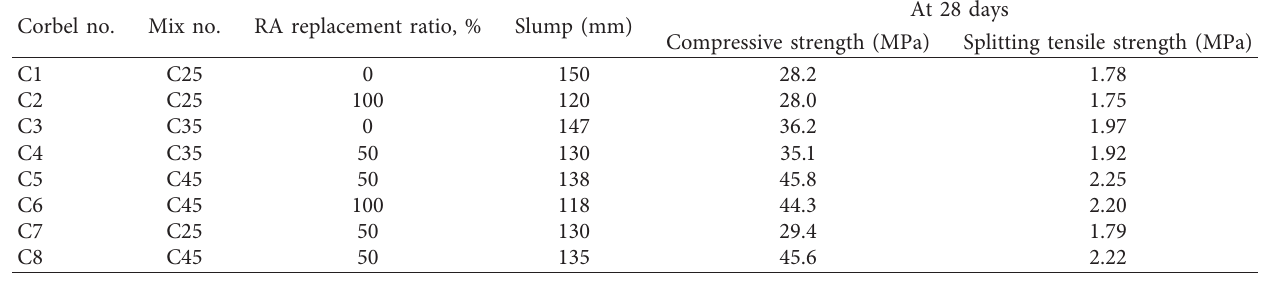
Table 7: The properties of fresh and hardened concrete.